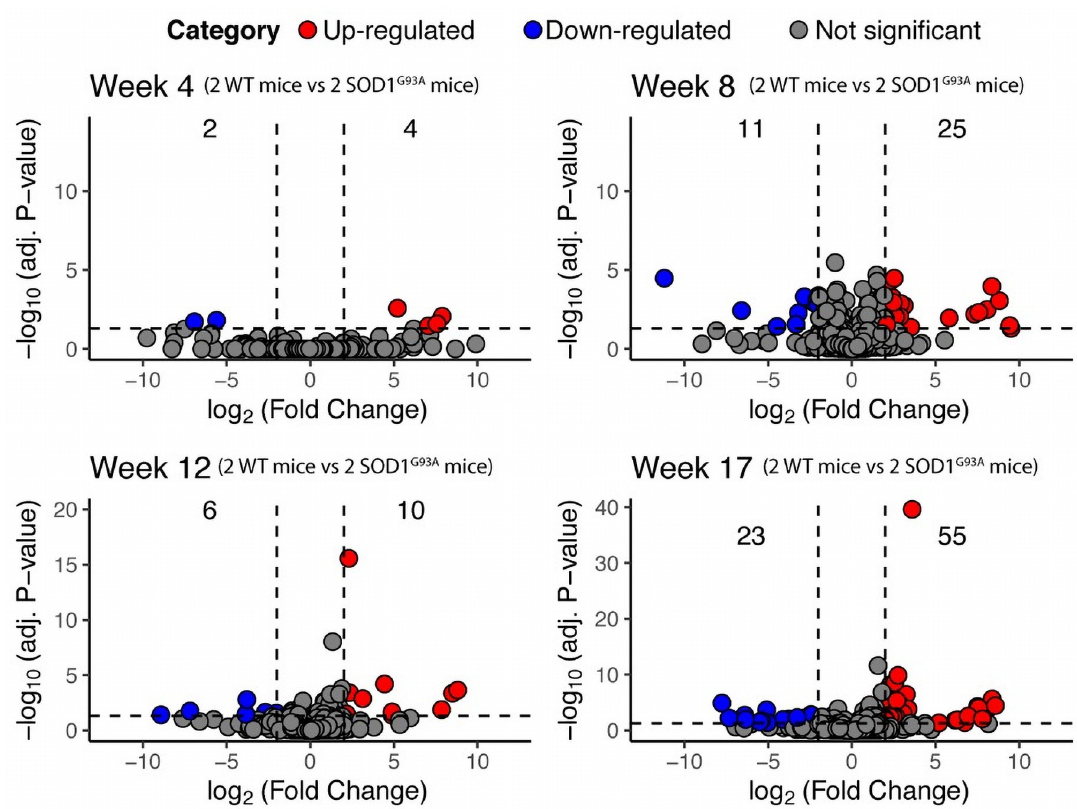
Fig 1. Volcano plots across the disease progression. For each plot, the log 2 (Fold Change) is shown in the x-axis, and the -log 10 (adjusted P-value) on the y-axis. The horizontal dashed line represents the adjusted P-value cutoff of 0.05, and the vertical dashed lines represent the log 2 (Fold Change) cutoffs at -2, and 2. Blue dots represent down-regulated TEs, and Red dots represent up-regulated TEs. Numbers at the upper left of each plot correspond to the number of down-regulated TEs, those at the center correspond to the TEs without significant changes in expression, and those at the upper right, to the number of up-regulated TEs. Below the number of the up- regulated and down-regulated TEs, percentages indicate the proportion of those TEs amongst all the expressed TEs found in the analyzed